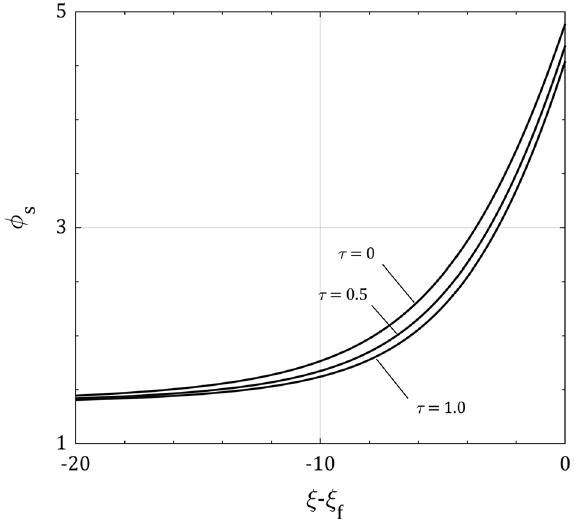
Figure 4. Normalized electric potential distribution φ for α curves illustrate the plasma asymptotic solution (solid curves for ǫ = 0 ) and the full solution (dashed curves for ǫ = 0.02 ).